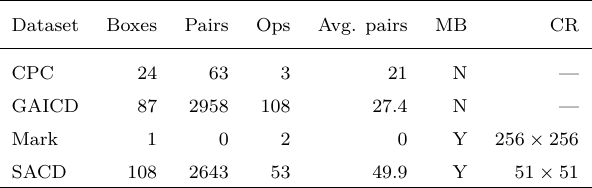
Table 1 Comparison of annotation processes Dataset